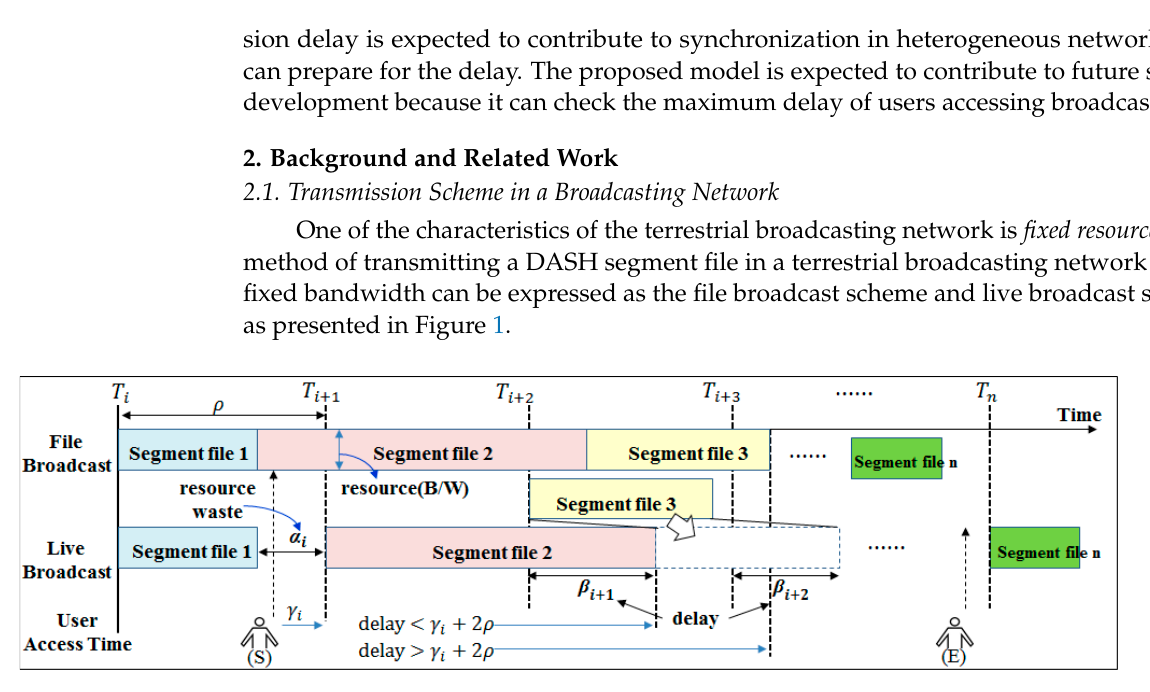
Figure 1. Transmission schemes that transmit segment files of variable sizes in a broadcasting network with fixed re- sources. The file broadcast scheme successively transmits segment files. The live broadcast scheme periodically transmits segment files.